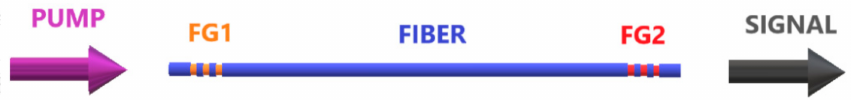
Figure 7. Schematic diagram of a chalcogenide glass fiber laser based on a three-level scheme realized using terbium ion doping proposed in